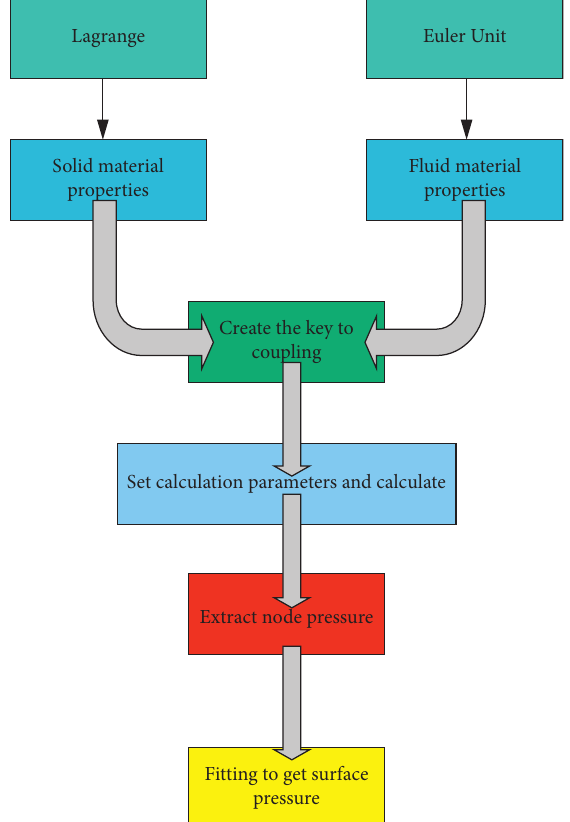
Figure 4: Impact load extraction flow chart.